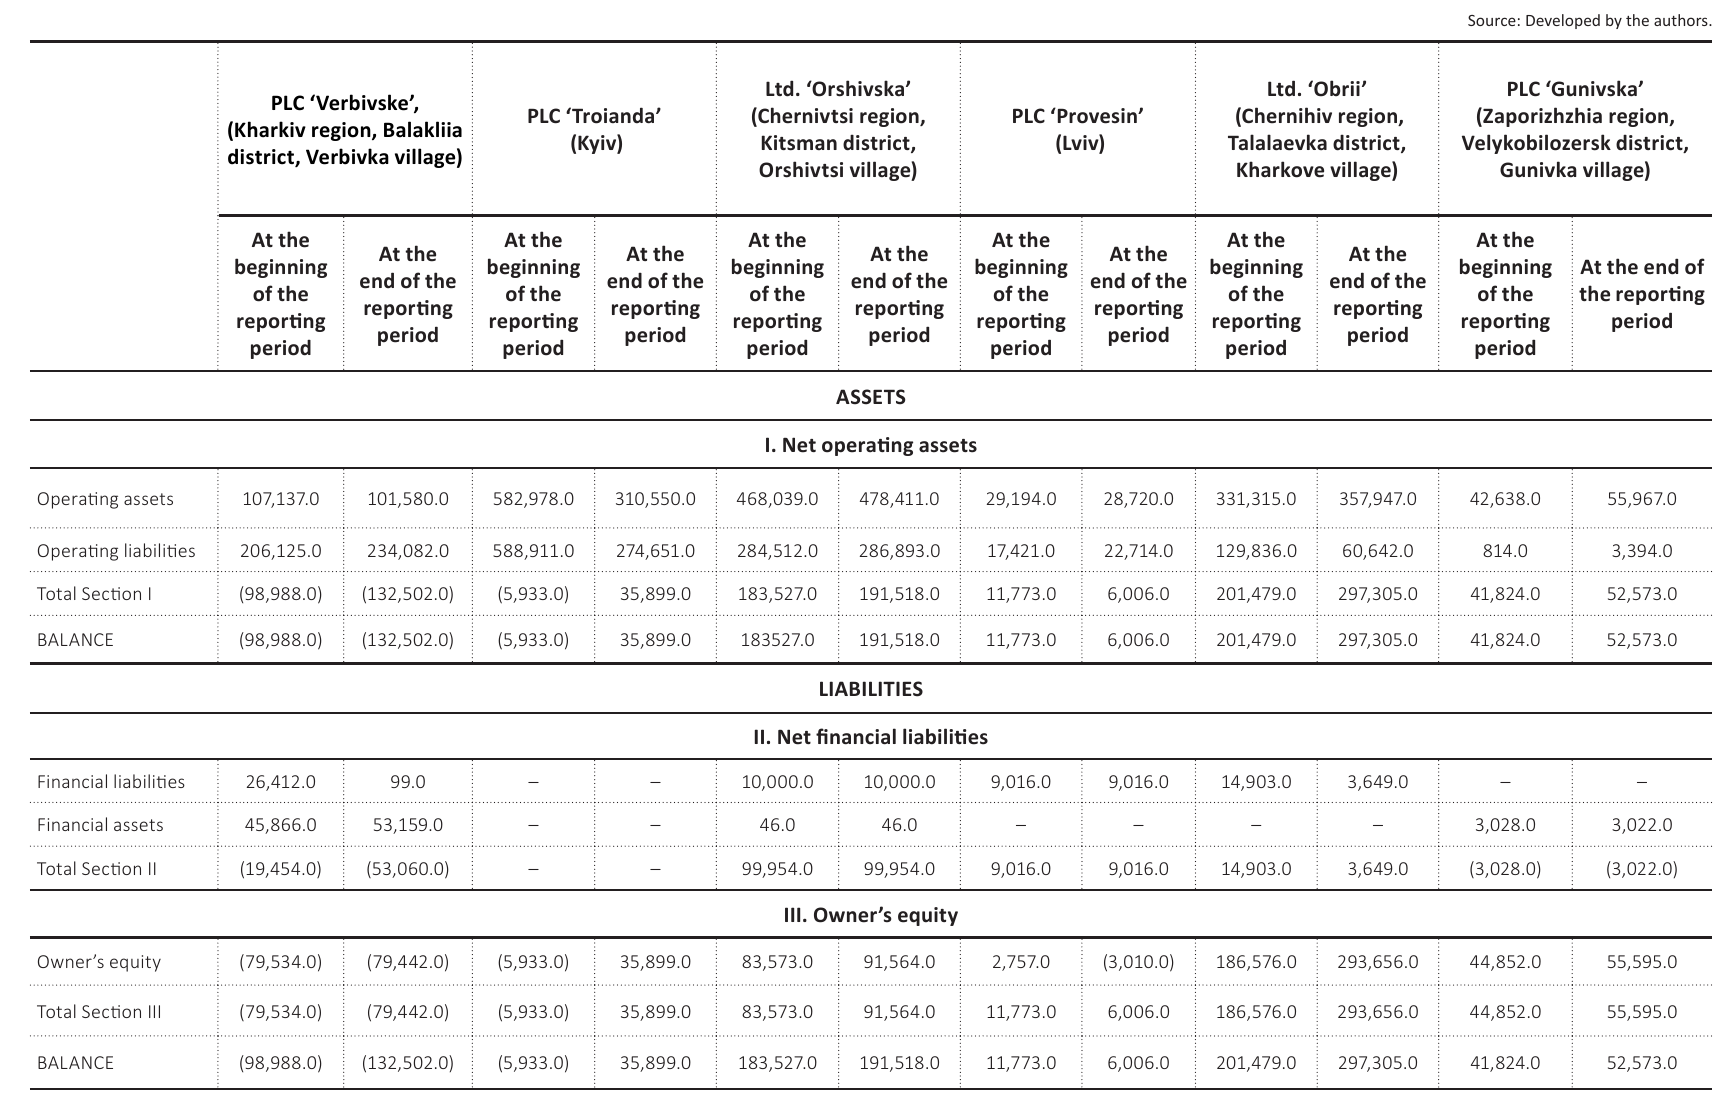
Table 1. Economic potential of agricultural enterprises through the lens of actuarial reports in 2018